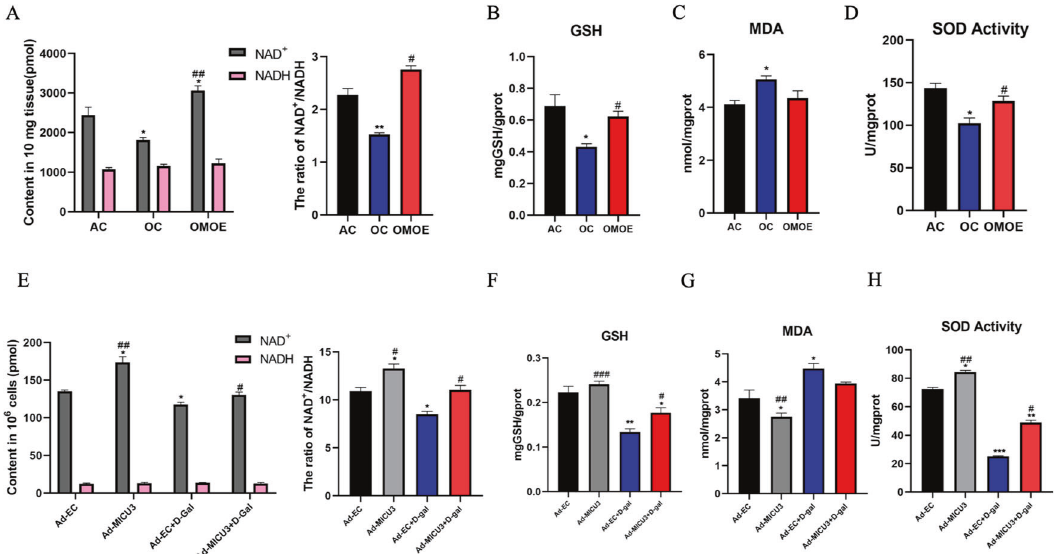
Fig. 6 MICU3-mediated mitochondrial Ca 2 + -enhanced antioxidant effect. A NAD + , NADH contents, and the ratio of NAD + and NADH in mice gastrocnemius muscle. B The GSH contents in mice gastrocnemius muscle. C The MDA contents in mice gastrocnemius muscle. D The activity of SOD in mice gastrocnemius muscle. * p < 0.05 vs. the AC group; # p < 0.05 vs. the OC group; n = 3 mice in each group. E NAD + , NADH contents, and the ratio of NAD + and NADH in C2C12 cells. F The GSH contents in C2C12 cells. G The MDA contents in C2C12 cells. H The activity of SOD in C2C12 cells. * p < 0.05 vs. the Ad-EC group; # p < 0.05 vs. the Ad-EC + D -gal group; n = 3. Data were expressed as means ± SEM, and data were analyzed using a one-way